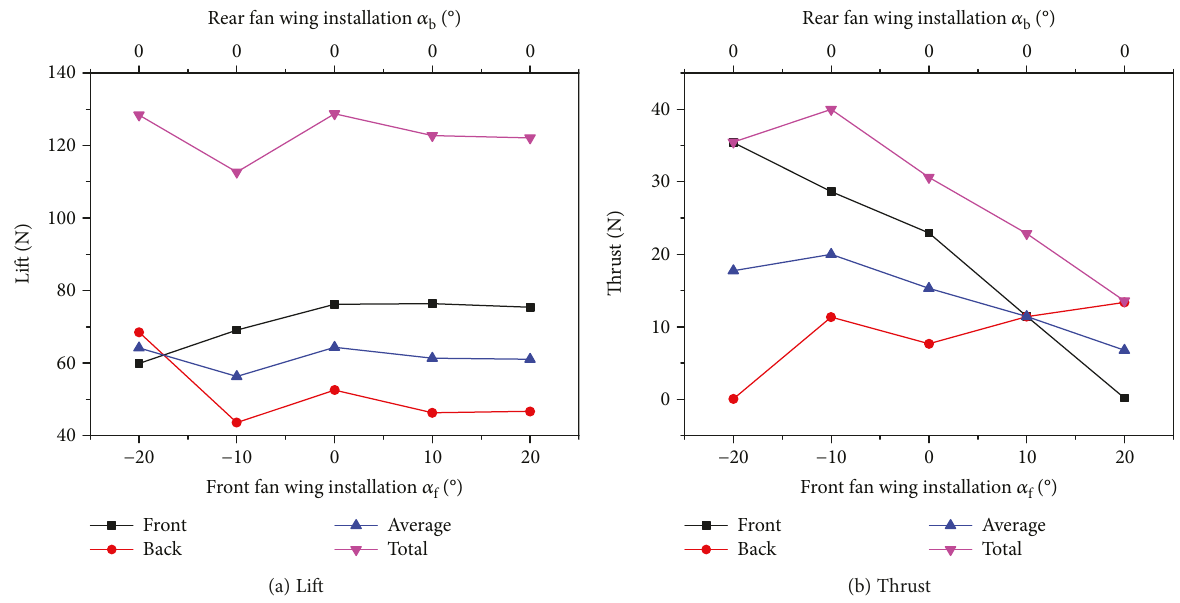
Figure 14: Curve of the lift and thrust of the front and rear fan wings when the rear wing is fi